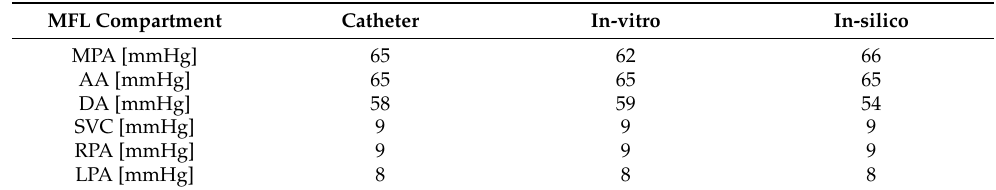
Table 7. Comparison of cycle averaged pressure [mmHg] data of patient 1 between catheter reports, in-vitro and in-silico measurements.